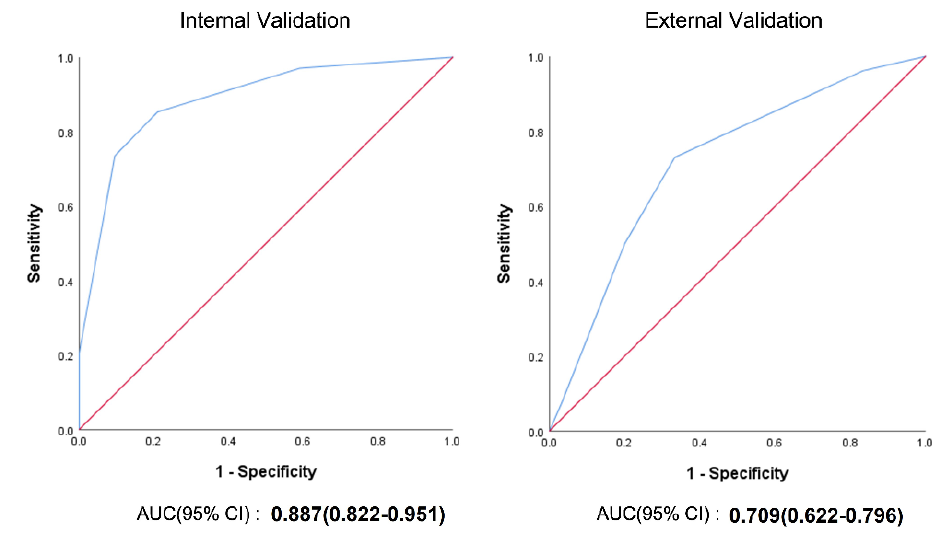
Figure 2. Receiver operating characteristic (ROC) curve and area under the curve (AUC) of the CoBiF score on internal and external validation.